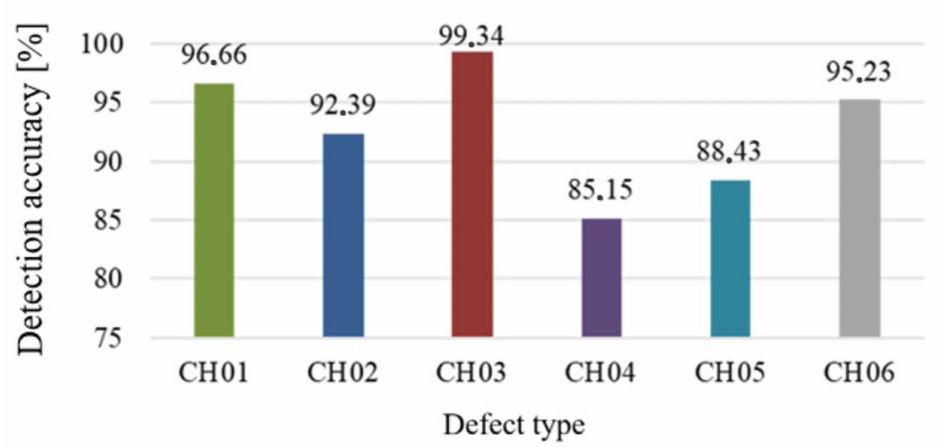
Figure 15. Comparison of the highest achieved values of different defects’